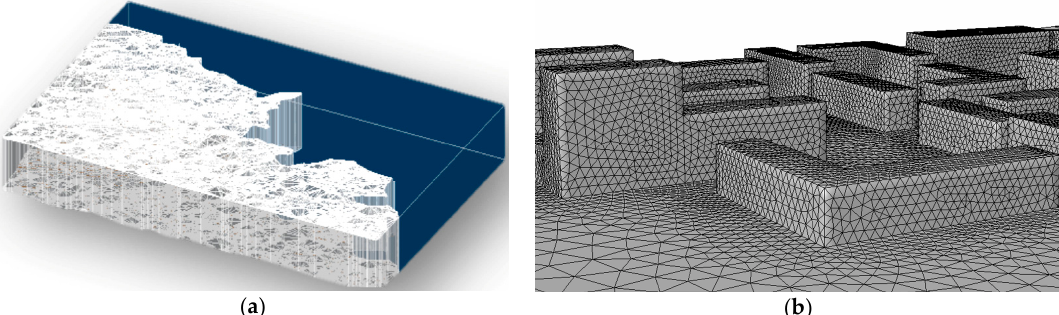
Figure 1. ( a ) Geometry representing an area of Gijón (dimensions of the domain: 14.5 km × 10 km × 1 km); ( b ) Details of the mesh taking into account the